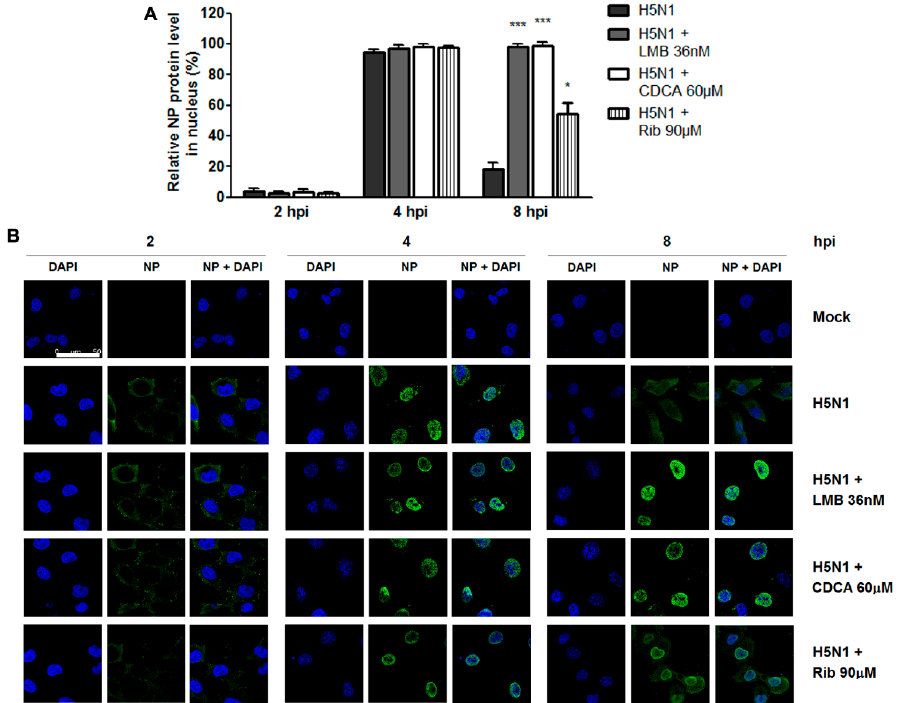
Figure 6. CDCA blocked viral RNP nuclear export. A549 cells were infected with H5N1 (1 MOI) for 1 h. After two washes with PBS, the cells were incubated in fresh medium containing CDCA or ribavirin or Leptomycin B (LMB). At the indicated timepoints, the cells were fixed and viral ribonucleoprotein (RNP) localization was determined by immunofluorescence staining. Cells were imaged using a confocal laser scanning microscope. Fluorescence optical densities in the whole cells or their nuclei were quantitated using software Image J. Results shown in A are the ratios of NP protein levels in the nuclei to that of the whole cells based on the fluorescence optical densities of the images from three independent experiments. Representative confocal IFA images out of three independent experiments were shown in B . Scale bar: 50 μ m. Statistical significances are denoted by * p < 0.05 and *** p < 0.001 compared to corresponding DMSO-control (H5N1).